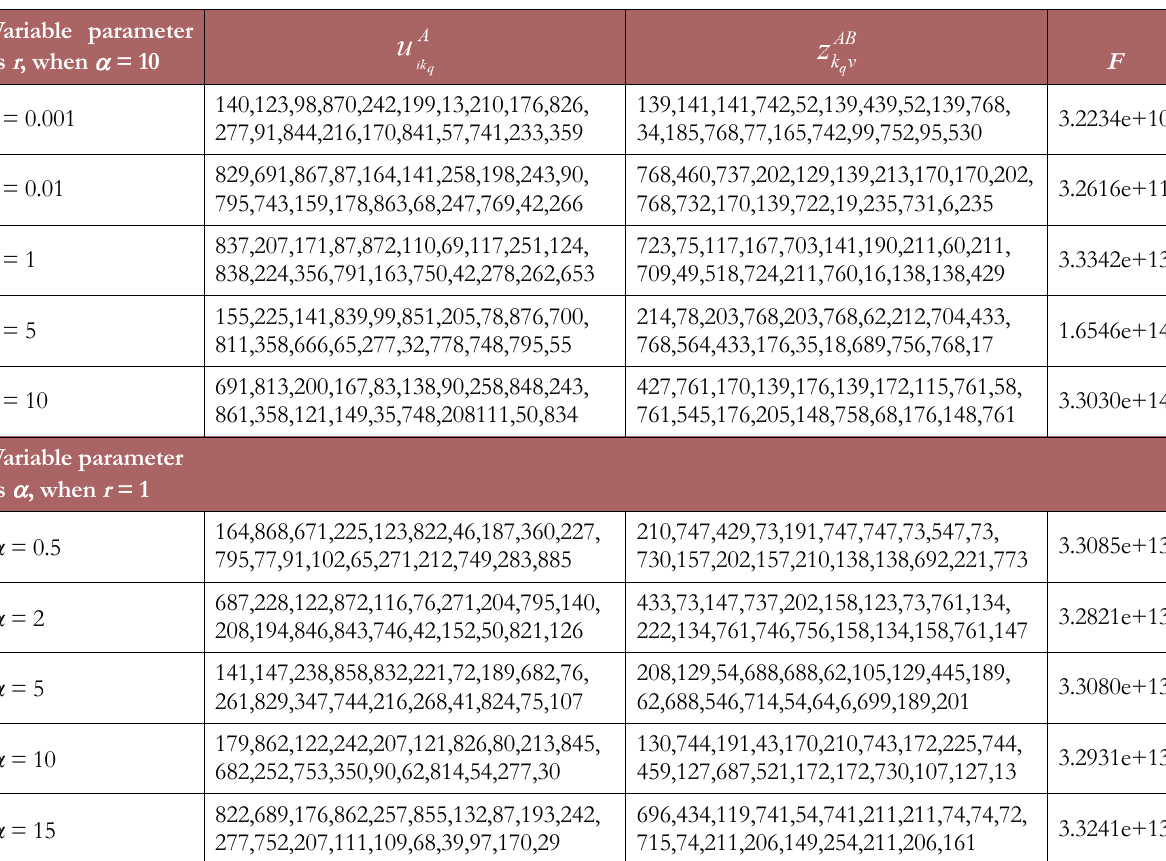
Table 2. Experimental results in the northern region